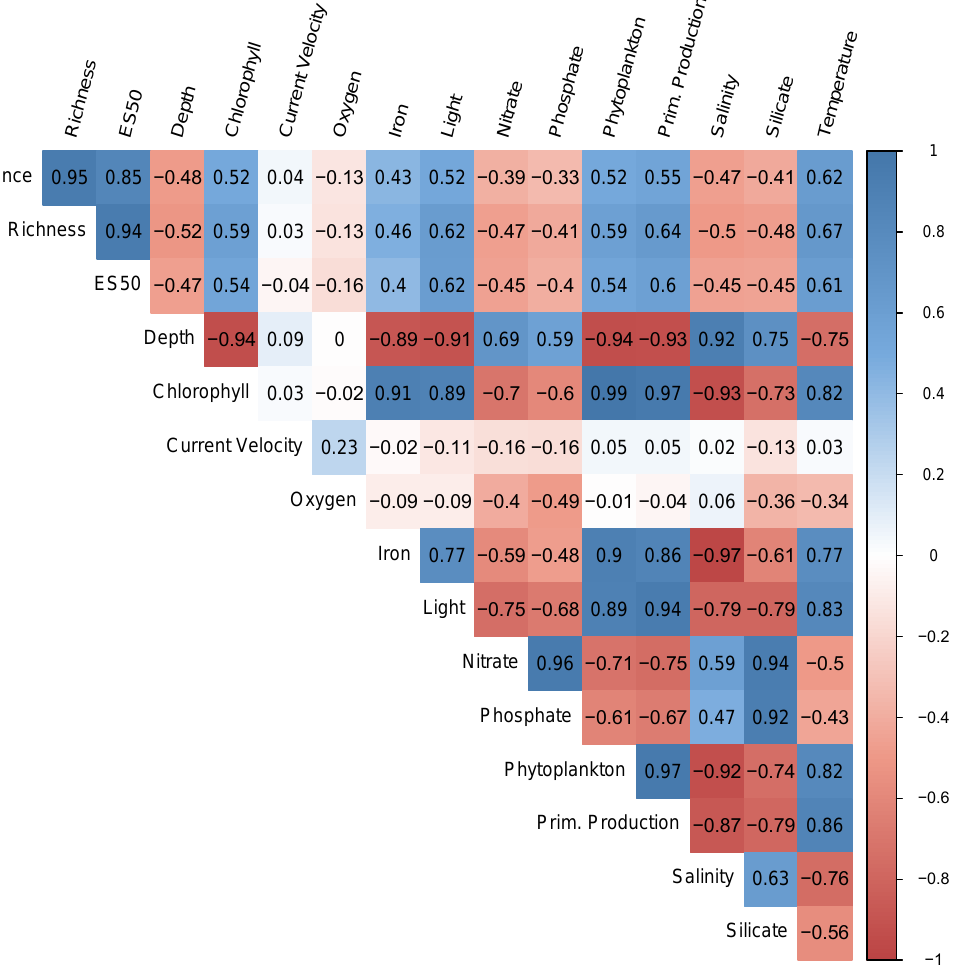
Figure 9. Correlation matrix of biodiversity parameters and environmental factors in the Northwest Pacific for Polychaeta and Sipuncula, with the 5% confidence value. The color red indicates a strong negative correlation, while blue indicates a strong positive correlation. We used ORACLE layers for the environmental factors and ran a Spearman correlation analysis between them and biodiversity parameters from the 700,000 km 2 hexagons: the alpha species richness (number of species), the sampling effort (number of occurrence records) and the estimated species richness (ES50).